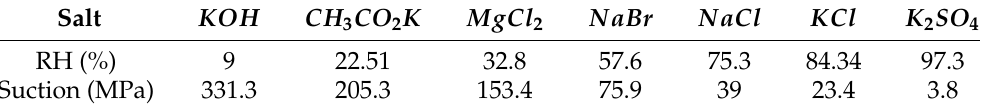
Table 1. Different saline solutions, the relative humidity, and corresponding suction imposed at 25